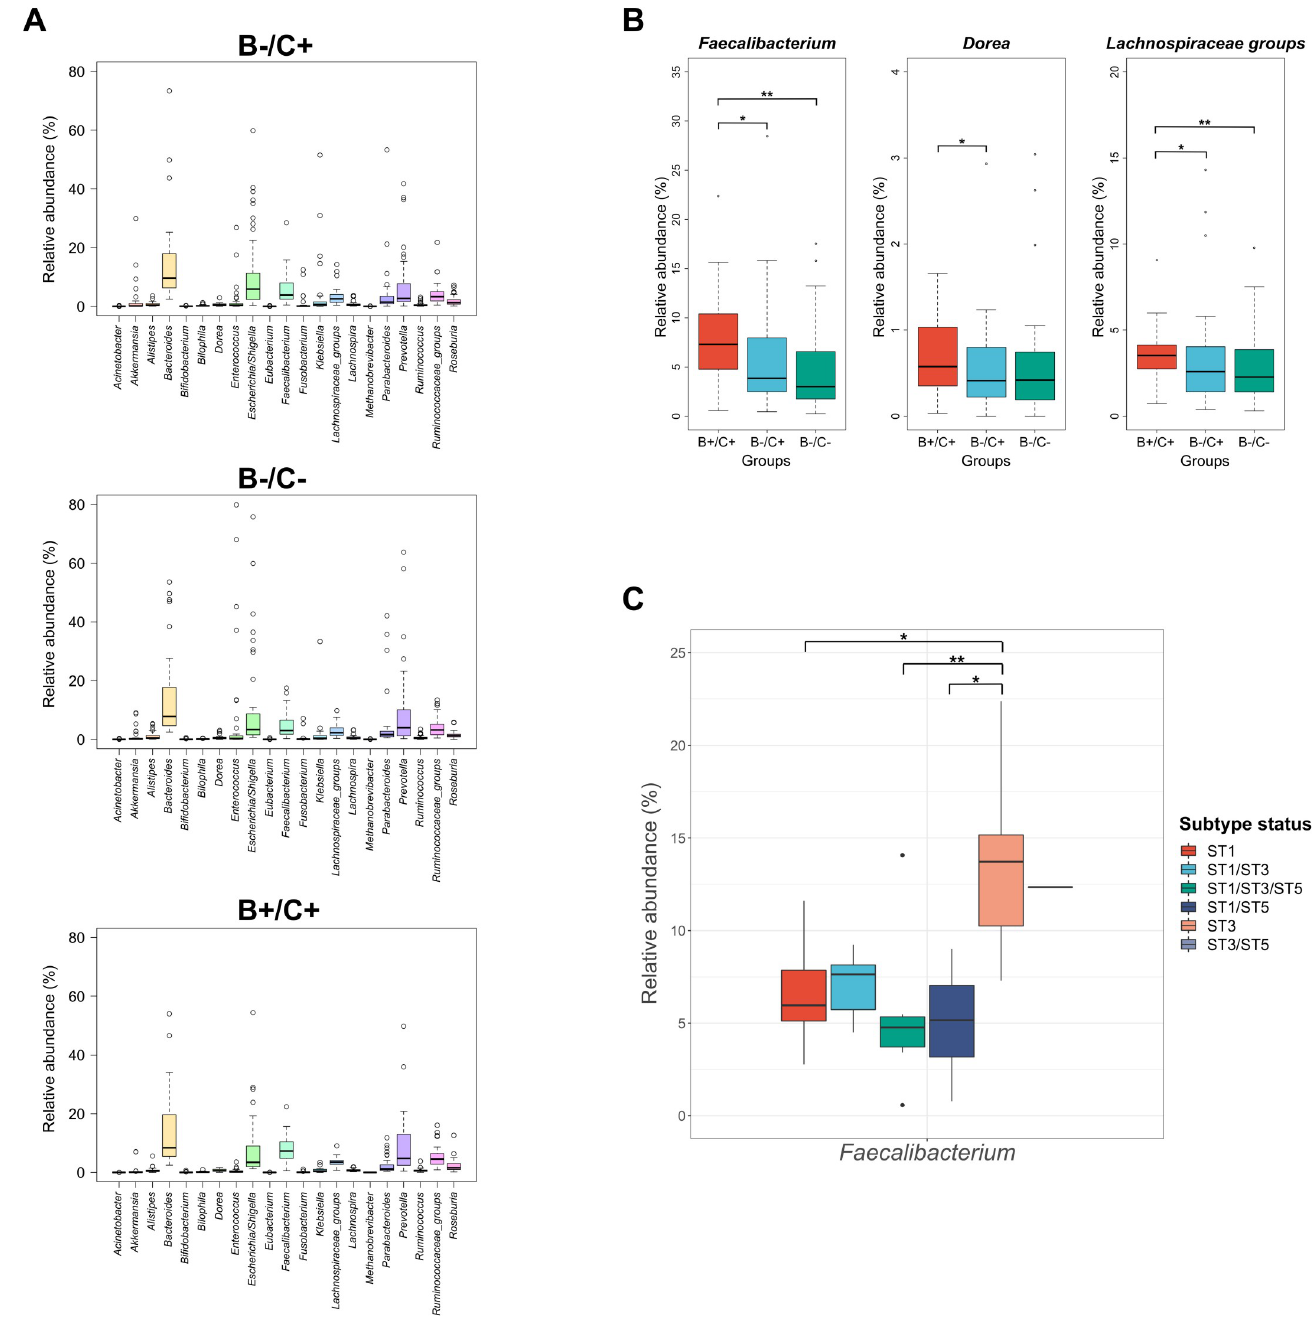
Fig 3. Description and evaluation of the statistical differences in the abundance of bacterial biomarkers among the three study groups. (A) Description of the relative abundance of 21 genera of bacteria considered as possible biomarkers of the intestinal microbiota among the three study groups. (B) Three genera of bacterial biomarkers presented significant differences in their relative abundance among some of the study groups, where all of these genera display a higher abundance in the B+/C+ group. (C) Changes in the relative abundance of Faecalibacterium considering the colonization of a determined Blastocystis subtype, showing that this genus has a higher abundance in ST3 colonized patients. Significant differences between the study groups were evaluated using Kruskal-Wallis test and ANOVA ( � , p < 0.05; �� , p < 0.01).